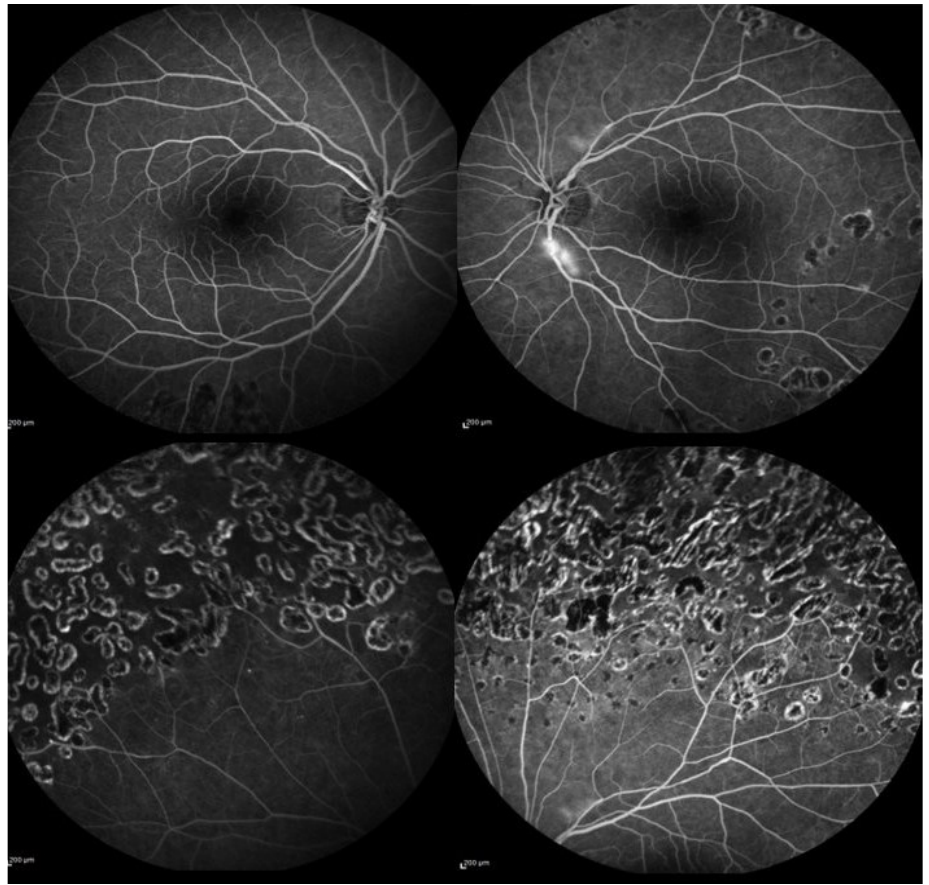
Figure 2. Fundus fluorescein angiography showing regression of retinal neovascularization in the left eye ( upper right ). Normal fundus appearance for the posterior pole in the right eye ( upper left ). Peripheral laser scars in both eyes ( lower left and right ).